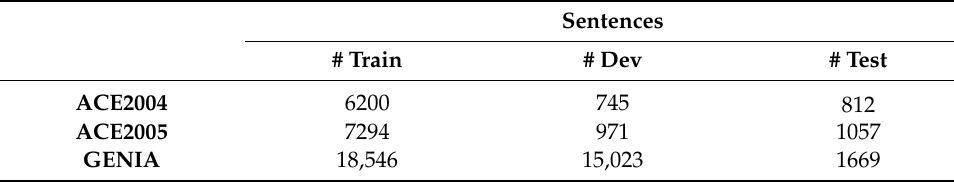
Table 2. Dataset Statistics.“#” denotes the amount.